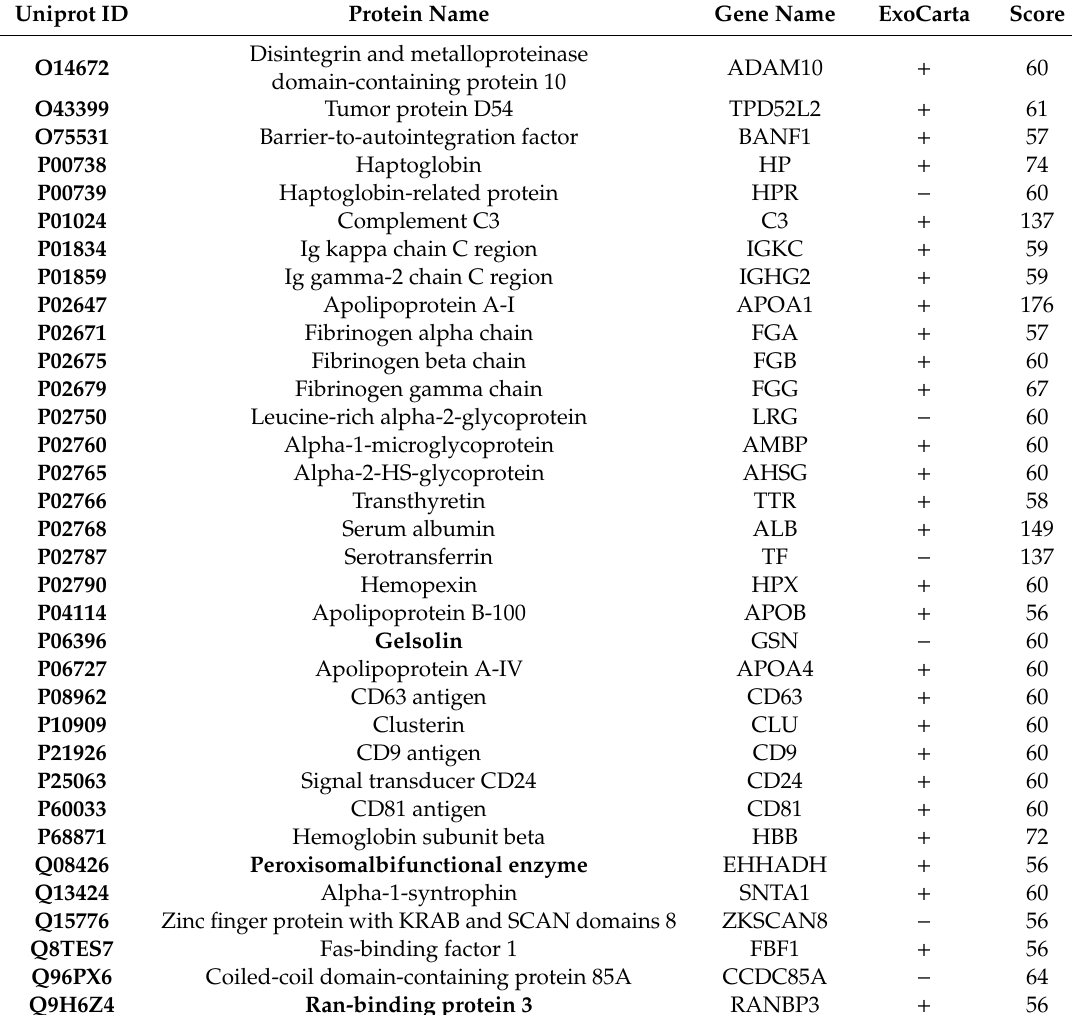
Table 5. Universal Exosomal Proteins Identified in the Blood of HFs and BCPs*.